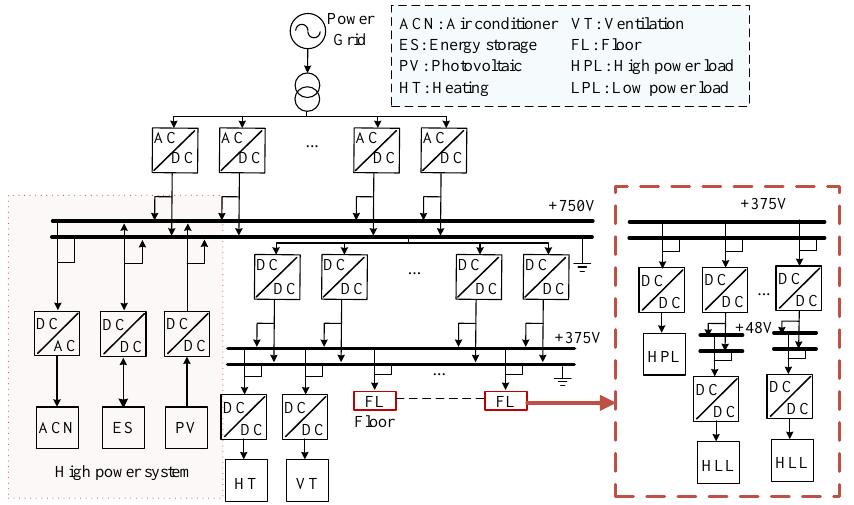
Figure 10. Centralized power supply topology.